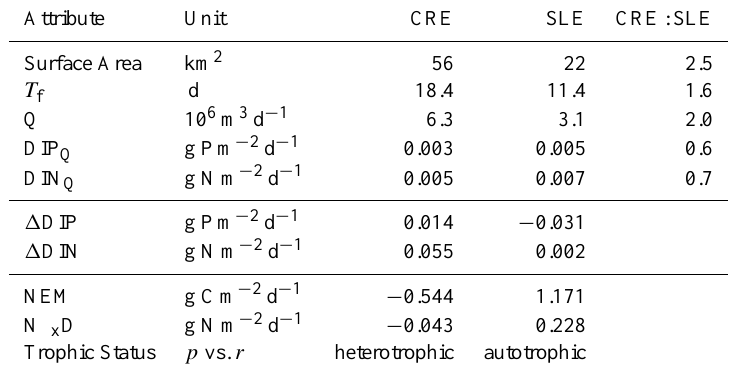
Table 5. Comparisons among attributes of CRE and SLE. Rate values were averaged across all DIP and DIN budgets derived for each estuary (2002–2008). Shown are estuary surface area, flushing time ( T f ), freshwater discharge ( Q ), daily DIP and DIN loading (DIP Q and DIN Q ), internal production ( + ) or consumption ( − ) of DIP and DIN ( 1 DIP and 1 DIN), net ecosystem metabolism (NEM) , and the relative difference between nitrogen fixation and denitrification (N fix D > 0.0 = net N 2 fixation; N fix D < 0.0 = net denitrification). The final row provides the trophic status in terms of production vs. respiration ( + NEM = p >r = autotrophic; − NEM = p <r = heterotrophic). The final column provides the ratio of values between the estuaries (CRE:SLE) in terms of surface area, T f , Q, and DIP Q and DIN Q .